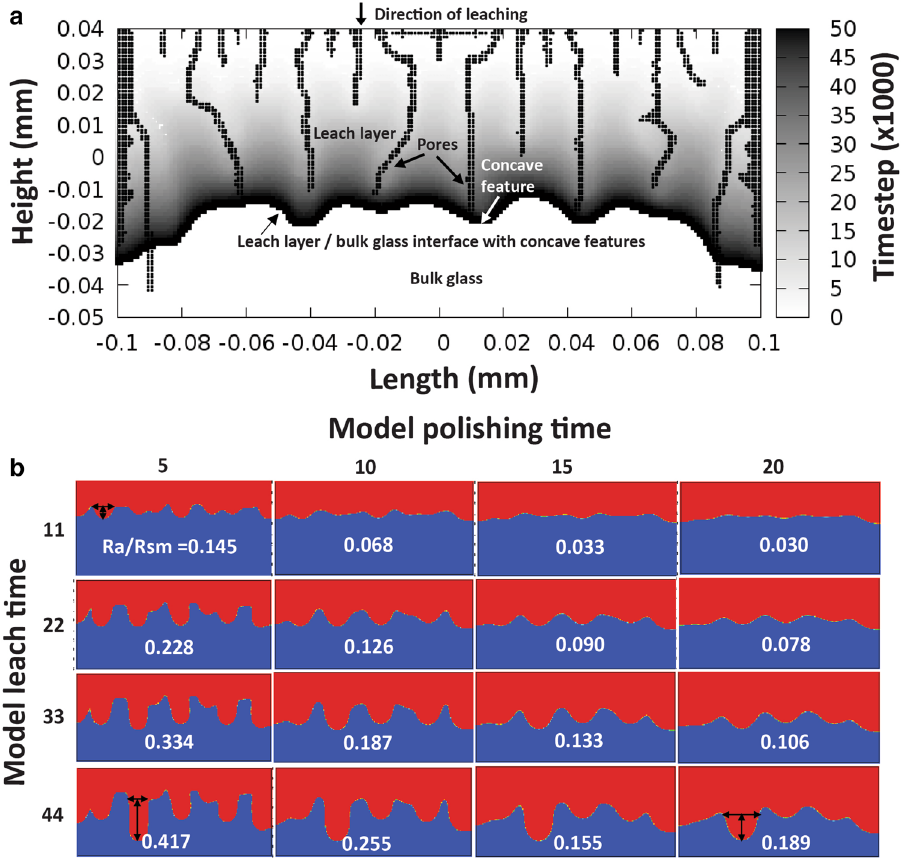
Figure 5. Modeling differential leaching and texturing process. ( a ) An “easily” hydrolyzed model with low value for the network strength (1 J/m 2 ), and “wide” pore channels having greater pore diffusivity than the leach layer’s (F pore = 30). The contours represent a growing formation of a textured interface between the leaching layer and bulk glass with the simulation time step. The small black dots represent the effective pores via material points with void fractions greater than 0.2. The effective pores (penetrating the leaching layer depth) create concave features at the interface, due to higher diffusivity within pores. The cross-section resembles the late stage iii shown in Fig. 1a. ( b ) Textured surfaces created by modeling etching and chemical polishing processes. Textures in the same row are modeled with constant leach time, textures in the same column are modeled with constant polishing time. Surface texture shape is defined by surface roughness (Ra, indicated by vertical arrows), feature size (Rsm, indicated by the horizontal arrows), and aspect ratio (Ra/Rsm). The aspect ratio of each modeled surface is labelled in each texture images. By comparing textures within the same column, surface features grow predominantly deeper and a little wider with longer leach time. By comparing the textures within the same row, surface features become shallower and